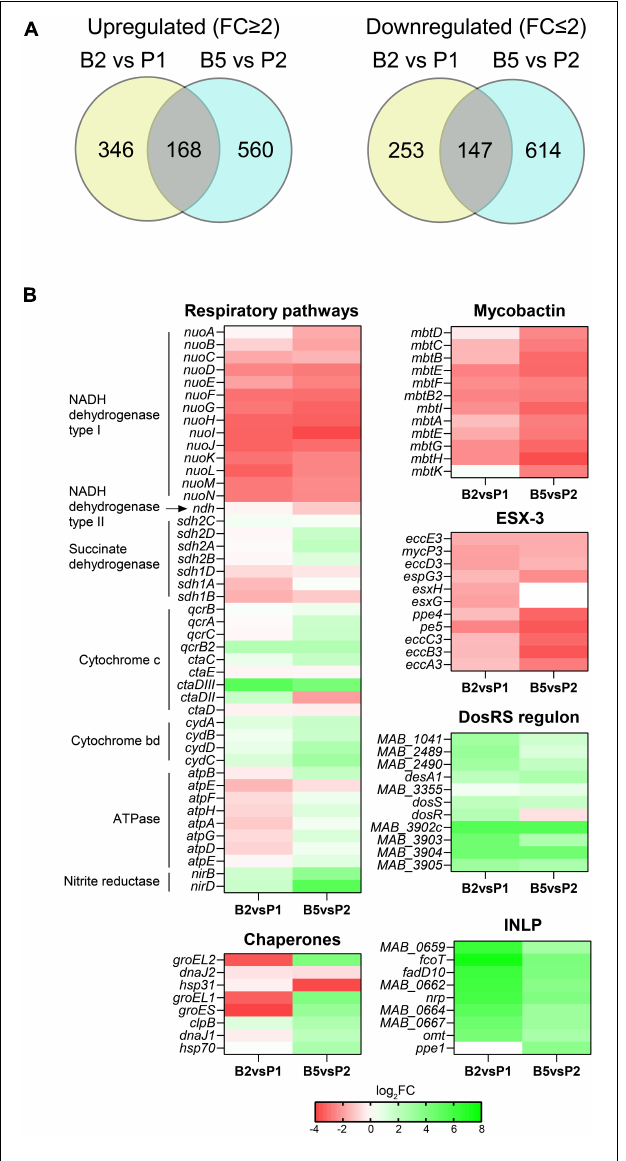
FIGURE 6 | Transcriptional profile of MABSC residing in biofilms. (A) Venn diagrams showing the number of genes expressed at significantly higher or lower levels in Mabs NJH12 biofilms at day 2 vs. Mabs NJH12 biofilms planktonic cultures at day 1 (B2 vs. P1) or biofilms at day 5 vs. planktonic cultures at day 2 (B5 vs. P2). (B) Heatmap showing changes in the expression of genes involved in a few selected pathways found to be enriched in our analyses. INLP genes are involved in the biosynthesis of isonitrile lipopeptides. ESX-3 and mycobactin are involved in iron acquisition. The DosR regulon is involved in the response to hypoxia and oxidative stress. The results of our complete functional enrichment analysis are presented in Supplementary Figure 4 .